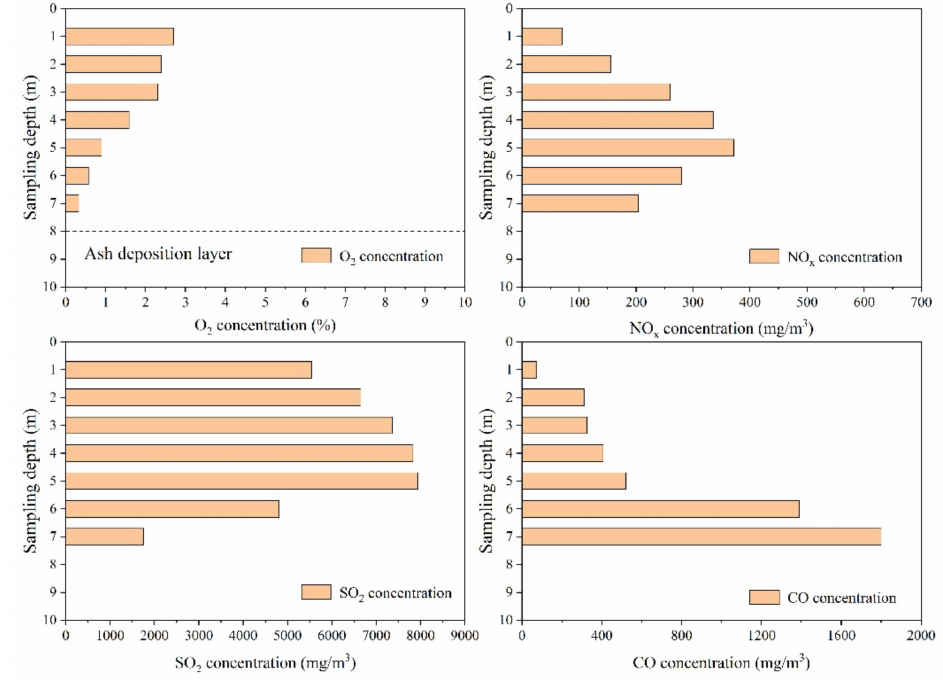
Figure 5. Vertical distributions of flue gas composition at the #A SNCR